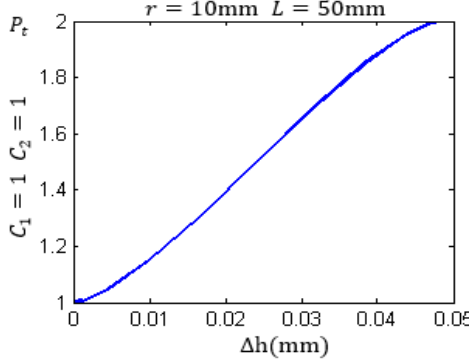
Figure 4. The relationship between the total energy P t and ∆ h